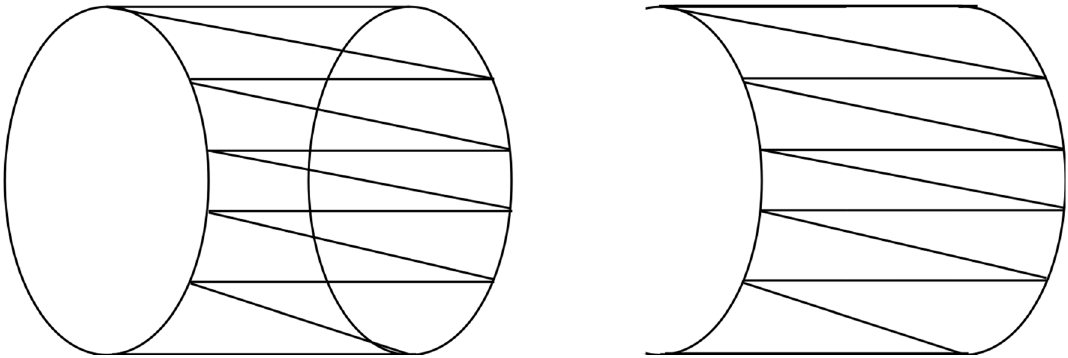
Figure 8. The grid of section and half cross section.